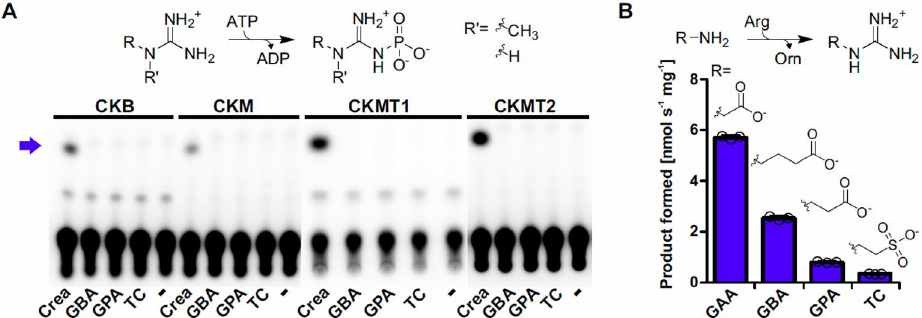
Figure 4. Formation of guanidino acids by GATM and their potential as phosphagens. (A ) Radiograph of the phosphorylation reaction of four different human creatine kinase isoforms. Recombinant human creatine kinases CKB, CKM, CKMT1 and CKMT2 were incubated with γ- 32 P-ATP and 10 mM of the respective substrate (creatine (crea), GBA, GPA, TC and no substrate (-)). Reaction products were separated by TLC with Silica 60 as stationary phase. A phosphorylation product was only observed for creatine (blue arrow) for all creatine kinase isoforms. ( B ) Reactions of human GATM with its main substrate glycine in comparison to GABA, β-alanine and taurine forming the canonical GATM product guanidinoacetic acid (GAA) or the guanidino acids GBA, GPA and TC, respectively. Columns represent the average of technical triplicates and consistent results were obtained with independent preparations. Error bars,